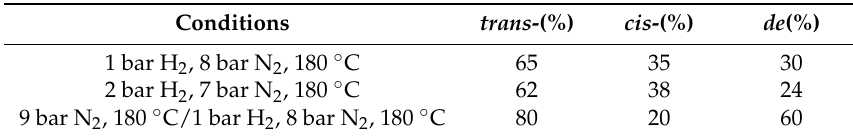
Table 11. Effect of reaction conditions on the content of amine ( 4 ) diastereomers and diastereomeric excess value at complete myrtenol conversion. Adapted from [138].